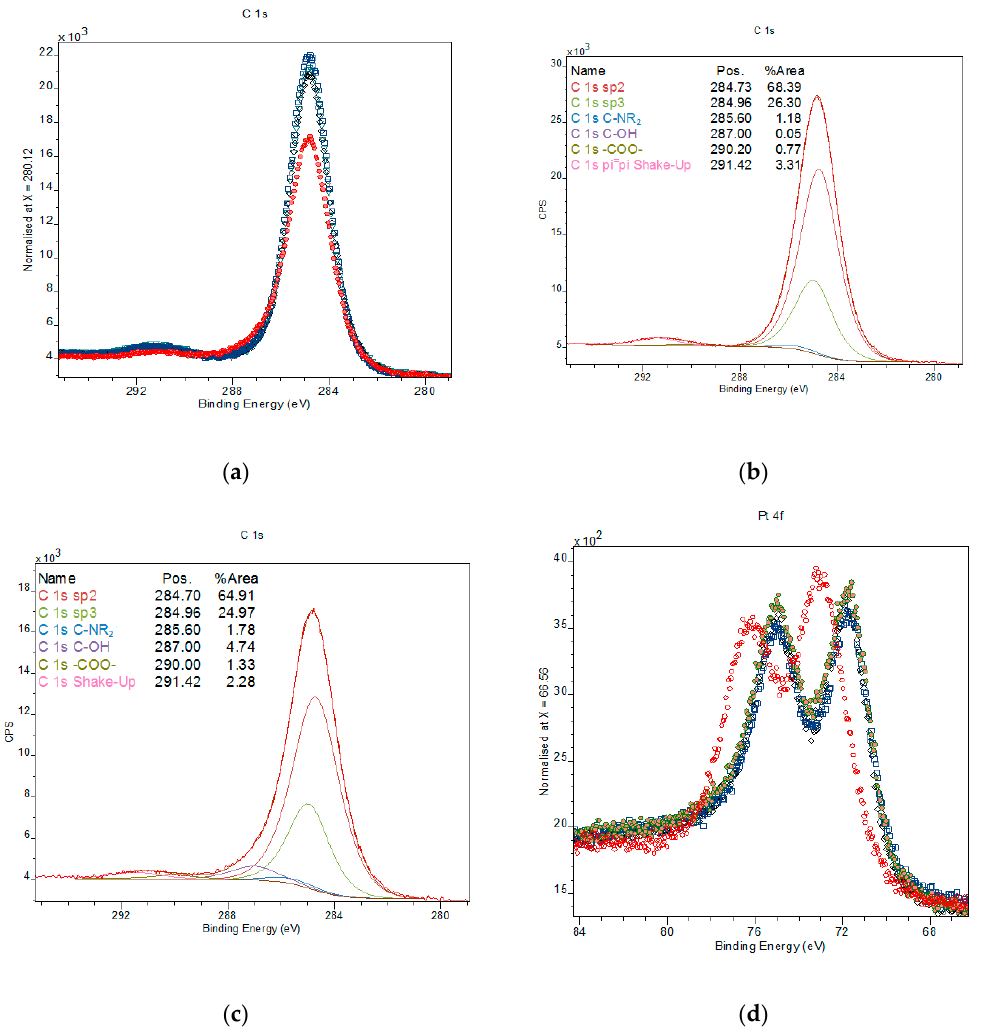
Figure 8. High-resolution spectrum of C 1s ( a ) for initial Pt-HAP (red circles) and the samples reduced for 3 h (green triangles), 12 h (blue squares) and 24 h (black rhombs) and deconvolution of C 1s of the Pt-HAP (initial ( b ) and reduced for 3 h ( c )) and high-resolution spectrum of Pt 4f ( d ).